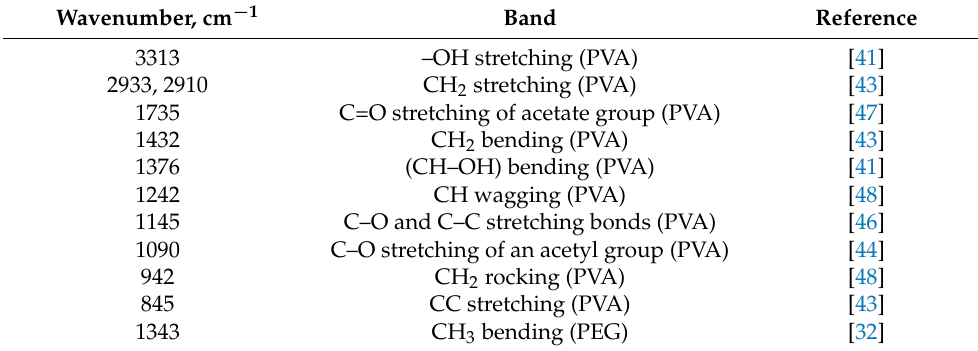
Table 1. FTIR bands attributed to PVA and